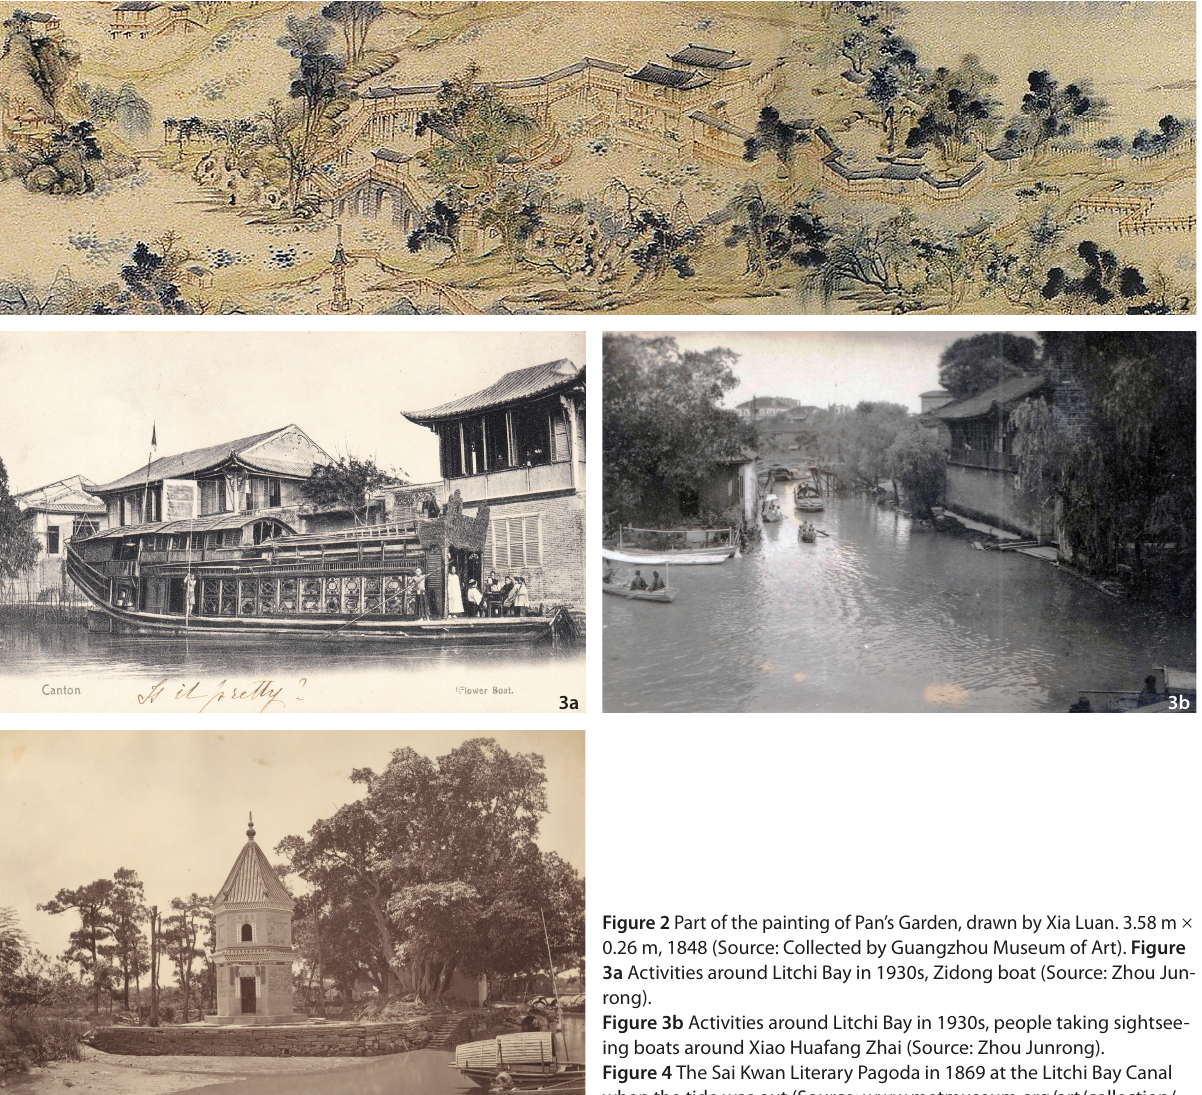
Figure 2 Part of the painting of Pan’s Garden, drawn by Xia Luan. 3.58 m × 0.26 m, 1848 (Source: Collected by Guangzhou Museum of Art). Figure 3a Activities around Litchi Bay in 1930s, Zidong boat (Source: Zhou Jun- rong). Figure 3b Activities around Litchi Bay in 1930s, people taking sightsee- ing boats around Xiao Huafang Zhai (Source: Zhou Junrong). Figure 4 The Sai Kwan Literary Pagoda in 1869 at the Litchi Bay Canal when the tide was out (Source: www.metmuseum.org/art/collection/ search/289341; attributed to John Thomson